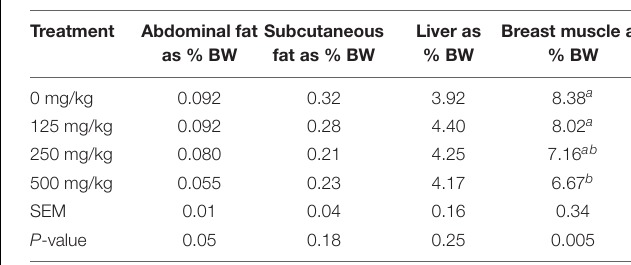
TABLE 2 | The effect of dietary baicalein supplementation on organ weights at day 6 post-hatch in Hubbard × Cobb-500 broilers 1 .